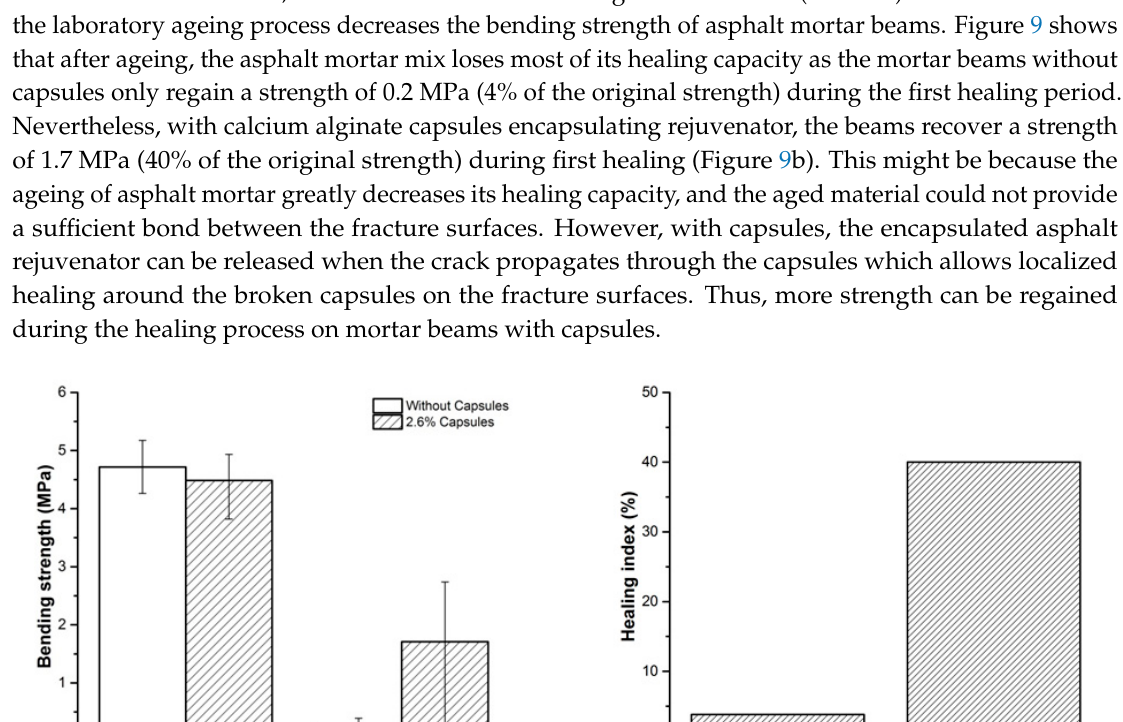
Figure 8. Bending strength of asphalt mortar beams.